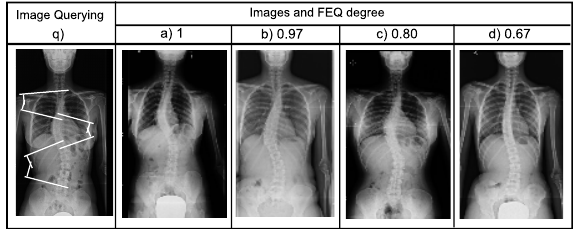
Fig. 3. Searching images that present similar spine curva- ture to image